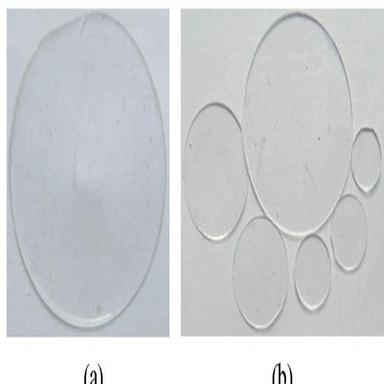
Samples from PDMS: whole sample of diameter ~46 mm (a) and produced disks of diameters 30, 18.1, 15, 10 and 8 mm (b).